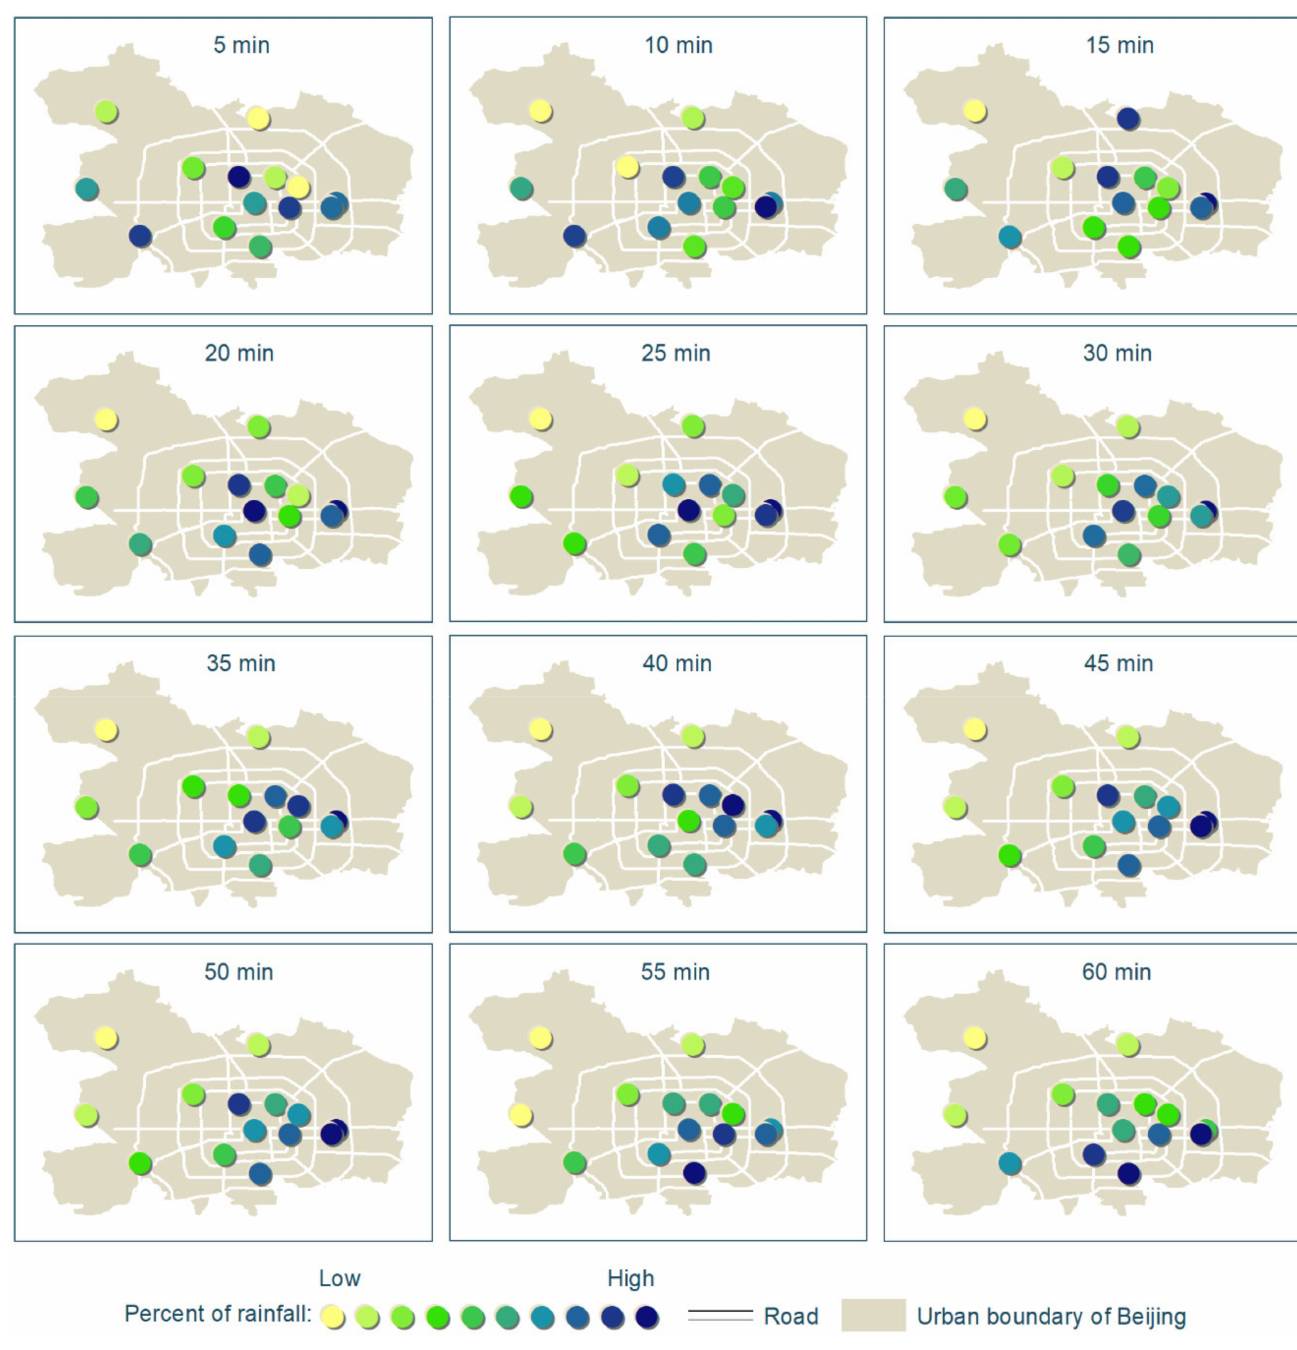
Figure 9. Spatiotemporal process of mode